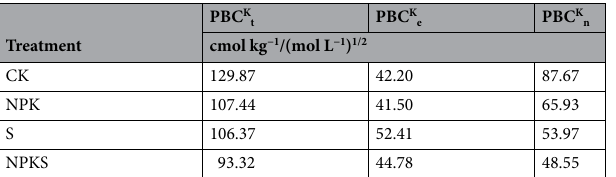
Table 4. Estimated equilibrium potential buffering capacity of K (PBC K ) [cmol kg −1 /(mol L −1 ) 1/2 ] of rice soil after 14 year of K fertilization. CK, no fertilization; NPK, mineral fertilizing; S, straw 6000 kg h m −2 and NPKS, NPK with straw 6000 kg h m −2 ; PBC K e = potential buffering capacity due to exchangeable K; PBC K n = potential buffering capacity due to non-exchangeable K; PBC K t = total potential buffering capacity.